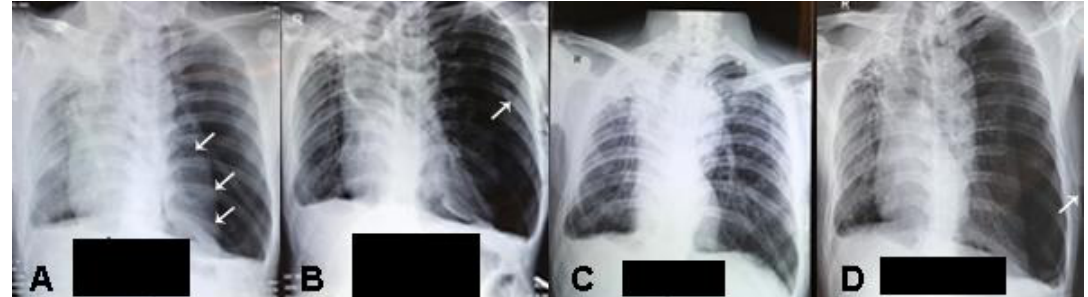
Figure 1. A. Chest X-ray when admitted to hospital, left-side pneumothorax; B. Chest X-ray after chest tube insertion procedure; C . Chest X-ray 4 th days after chest tube insertion, left lung fully expanded; D. Clinical status patient deteriorated, and repeat Chest X-ray (19 th day) revealed persistent left pneumothorax, Heimlich valve performed (indicated by arrow).